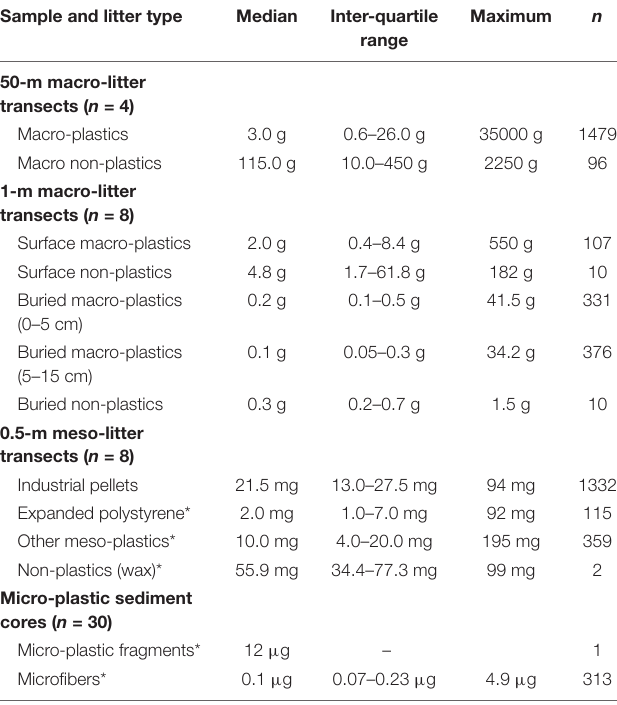
TABLE 1 | The median and maximum masses of litter items sampled at different spatial scales on a beach in the West Coast National Park, South Africa, in 2010 (macro- and meso-litter) and 2017